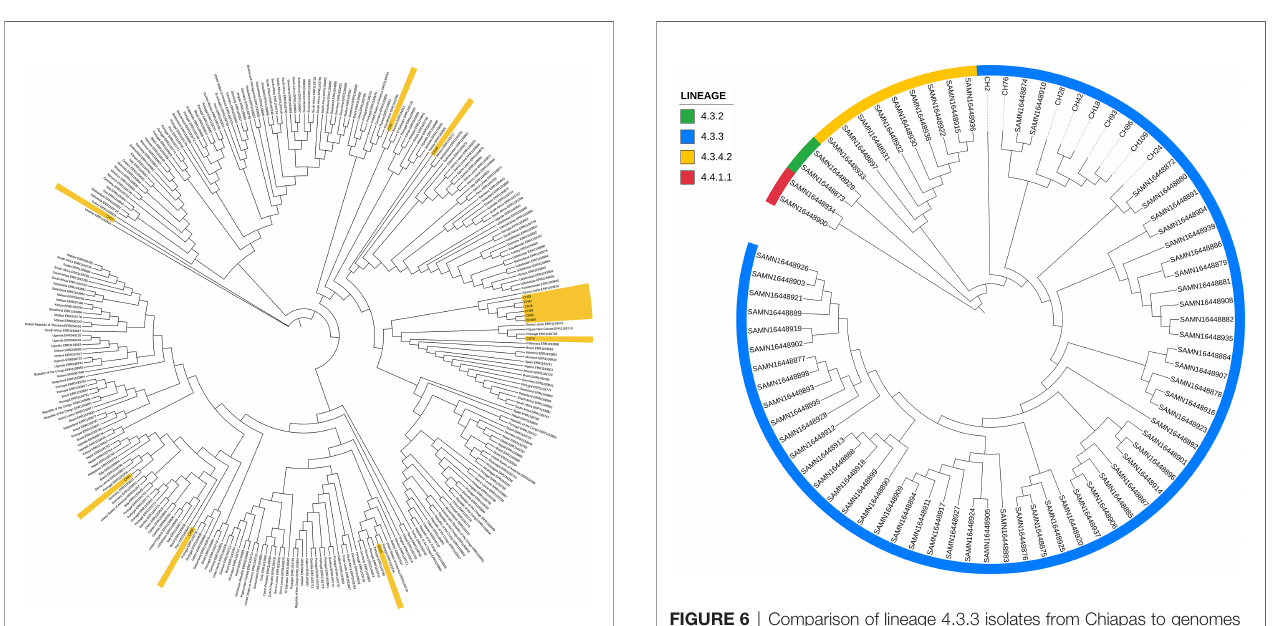
FIGURE 5 | Genome-based phylogeny map of lineage 4.3 isolates from Chiapas, belonging to SIT42 and orphan SITs, and 293 genomes of 4.3 sub- lineage isolates from the world. In yellow, we show those from our study.